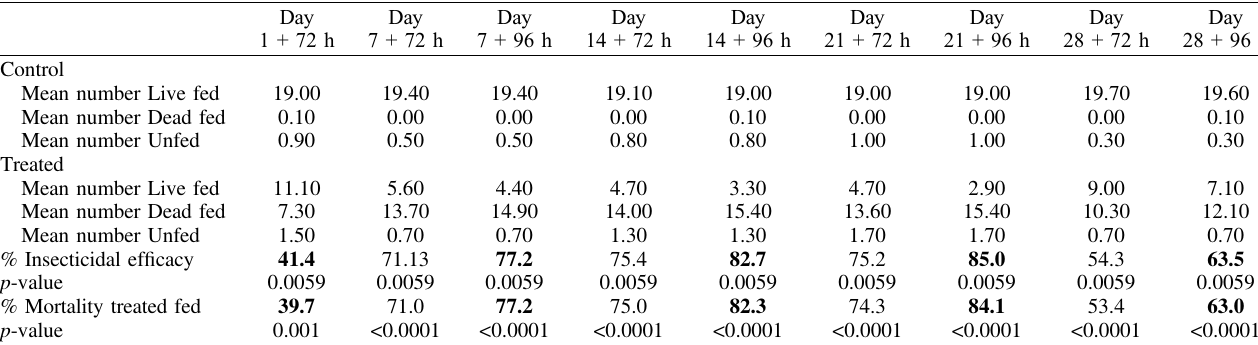
Table 1. % Insecticidal and % mortality observed on bedbugs at 72 h and 96 h post 15 min feeding exposure to dogs (arithmetic means).